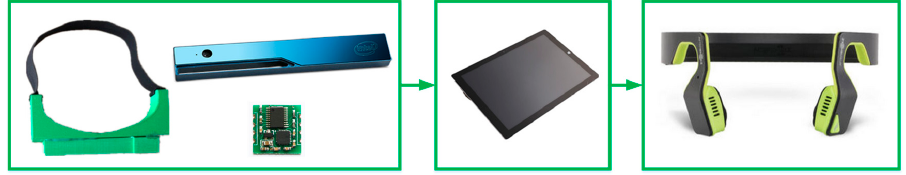
Figure 12. The assisting system consists a frame which holds the RealSense R200 and the attitude sensor, a processor, and a bone-conducting headphone.